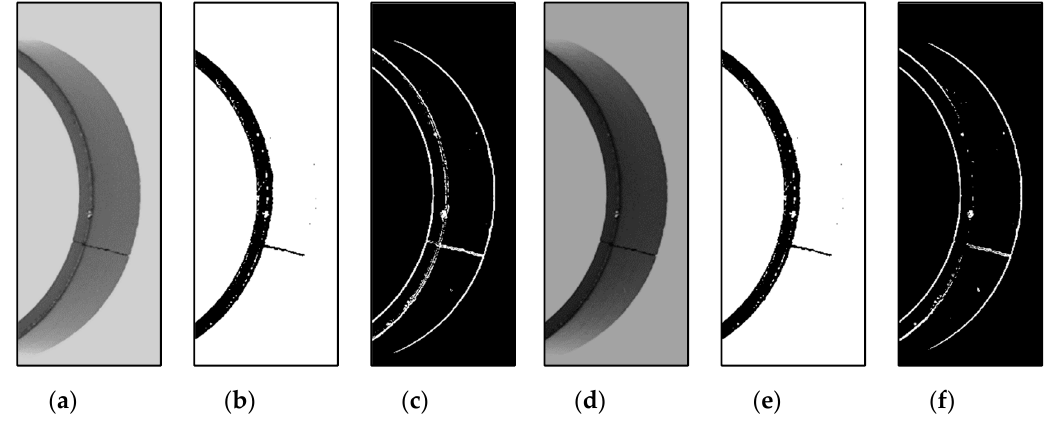
Figure 9. ( a – f ) Torus gray binary images.